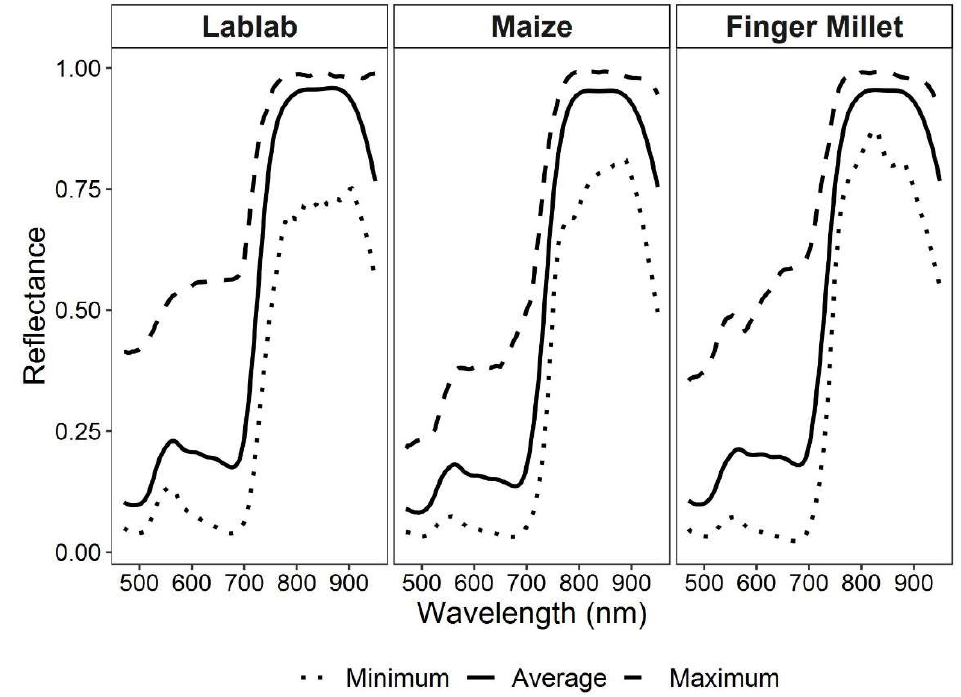
Figure 4. Minimum, average and maximum spectral reflectance curves of lablab, maize and finger millet for three levels of N and two levels of water supply during the three monsoon seasons.